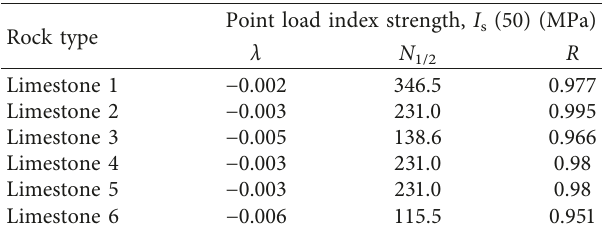
Table 6: The decay constant ( λ ), half-life ( N correlation ( R ) of point load index strength ( I s (50)).